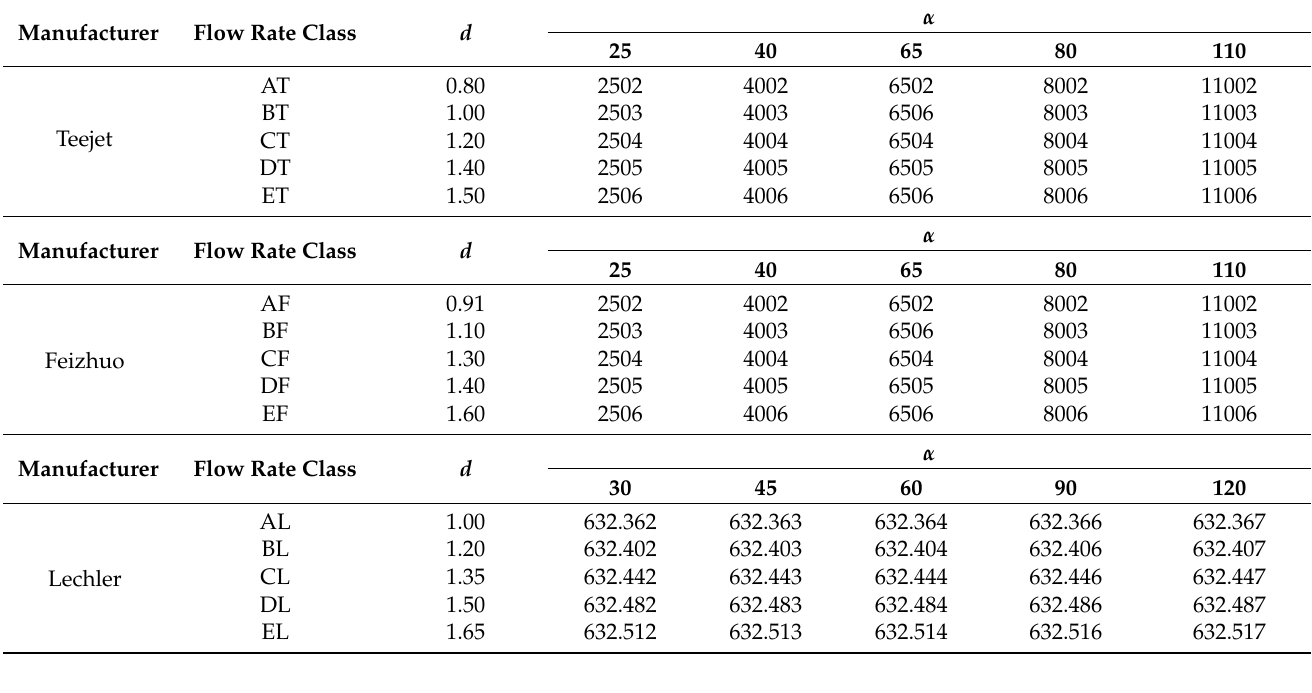
Table 1. Nozzle types of the three brands for mapping. The flow rate increases in the order of AT to ET, AF to EF, and AL to EL. At a pressure of 0.30 MPa, AT–ET are 0.79, 1.18, 1.58, 1.97, and 2.37 L/min, AF–EF are 0.79, 1.20,1.60, 1.90, and 2.40 L/min, and AL–EL are 0.77, 1.23, 1.53, 1.96, and 2.33 L/min.